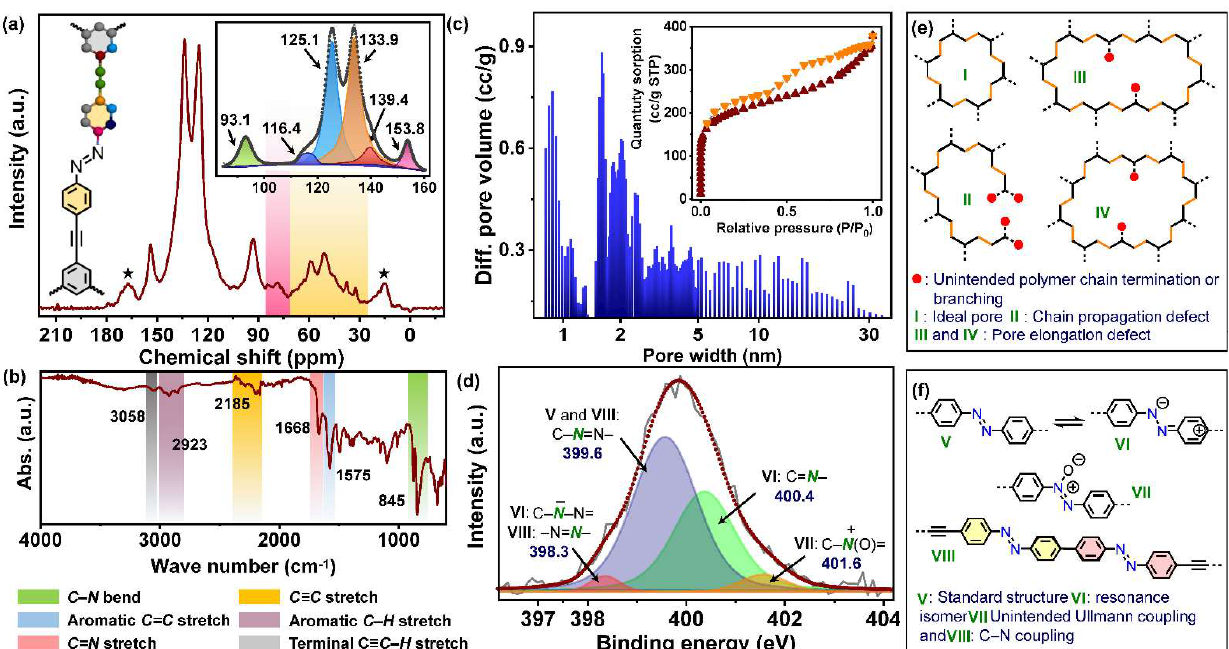
Figure 2. ( a ) Solid-state 13 C NMR spectrum of AzoCPP with the chemical backbone of the polymer repeating unit and corresponding color-coded NMR deconvolution peaks (inset); ( b ) FTIR spectrum of AzoCPP highlighting major IR bands; ( c ) the hierarchical porosity distribution of AzoCPP as obtained from NLDFT calculation and corresponding Ar sorption isotherm (inset); ( d ) deconvoluted N1s XPS spectra; and the intuitive polymer defects originating from ( e ) inefficient chain propagation and ( f ) unintended chemical reactions.